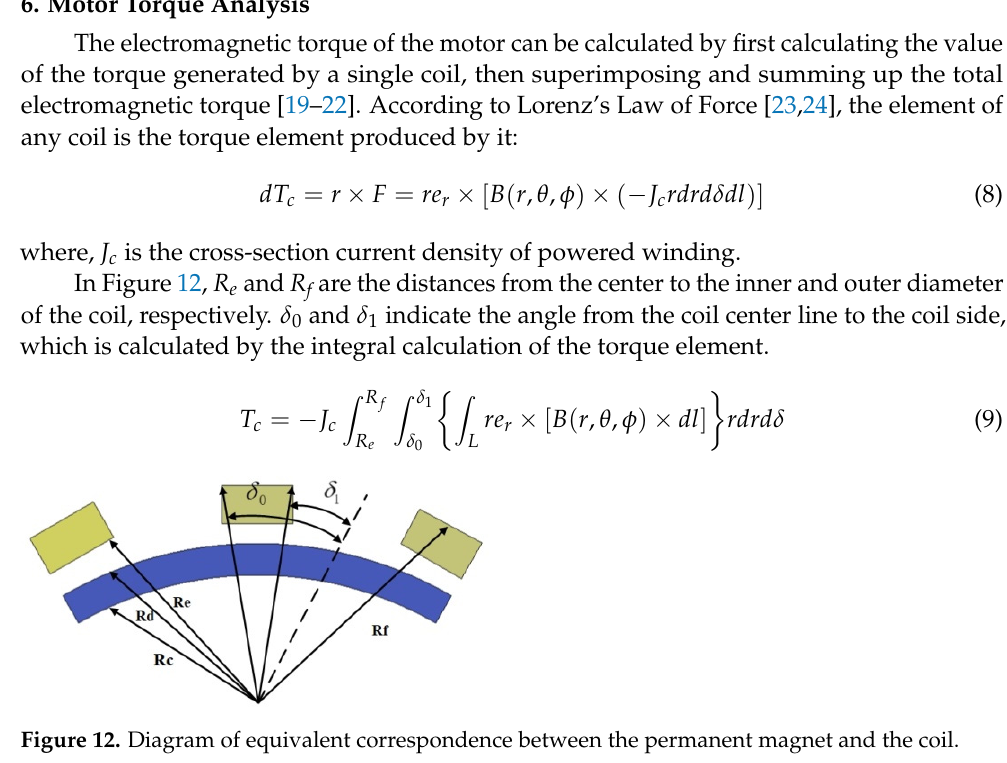
Figure 12. Diagram of equivalent correspondence between the permanent magnet and the coil.